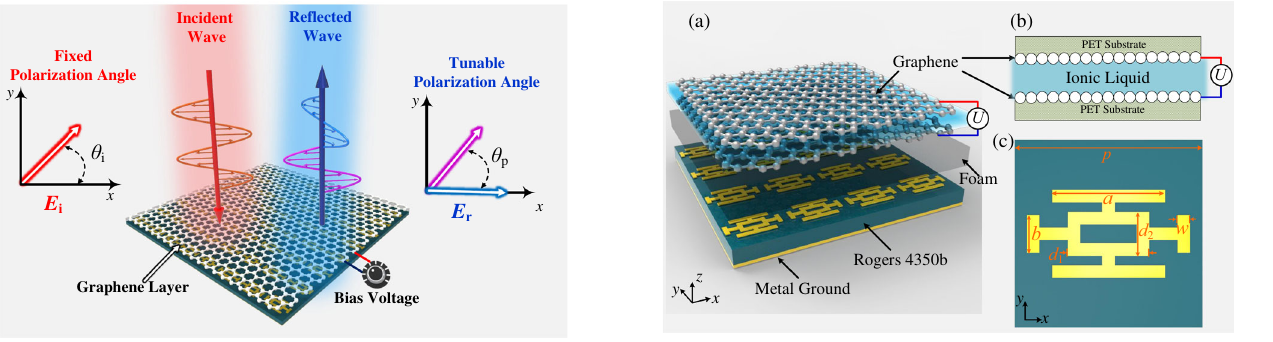
Fig. 1 Working principle of the proposed graphene-based meta- device. The proposed meta-device is capable of dynamically rotating the polarization angle of incident waves.